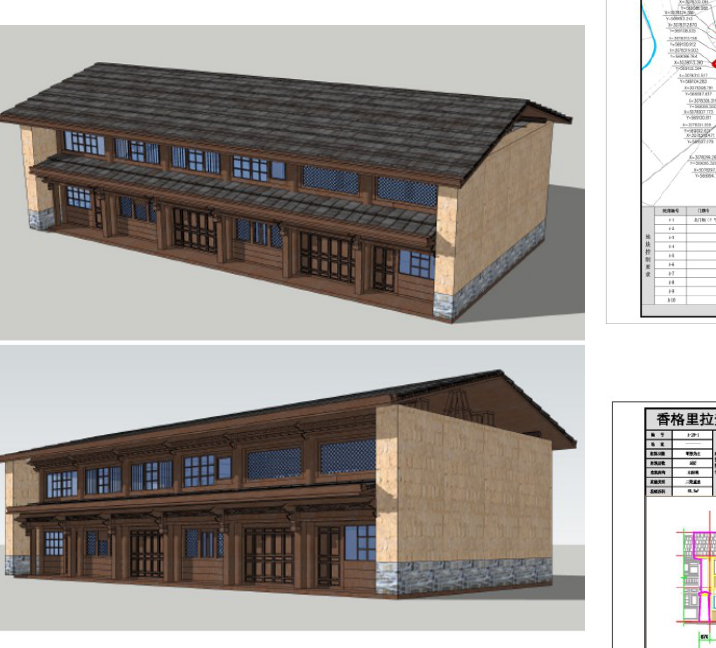
Figure 8. Reconstruction Design of the Court